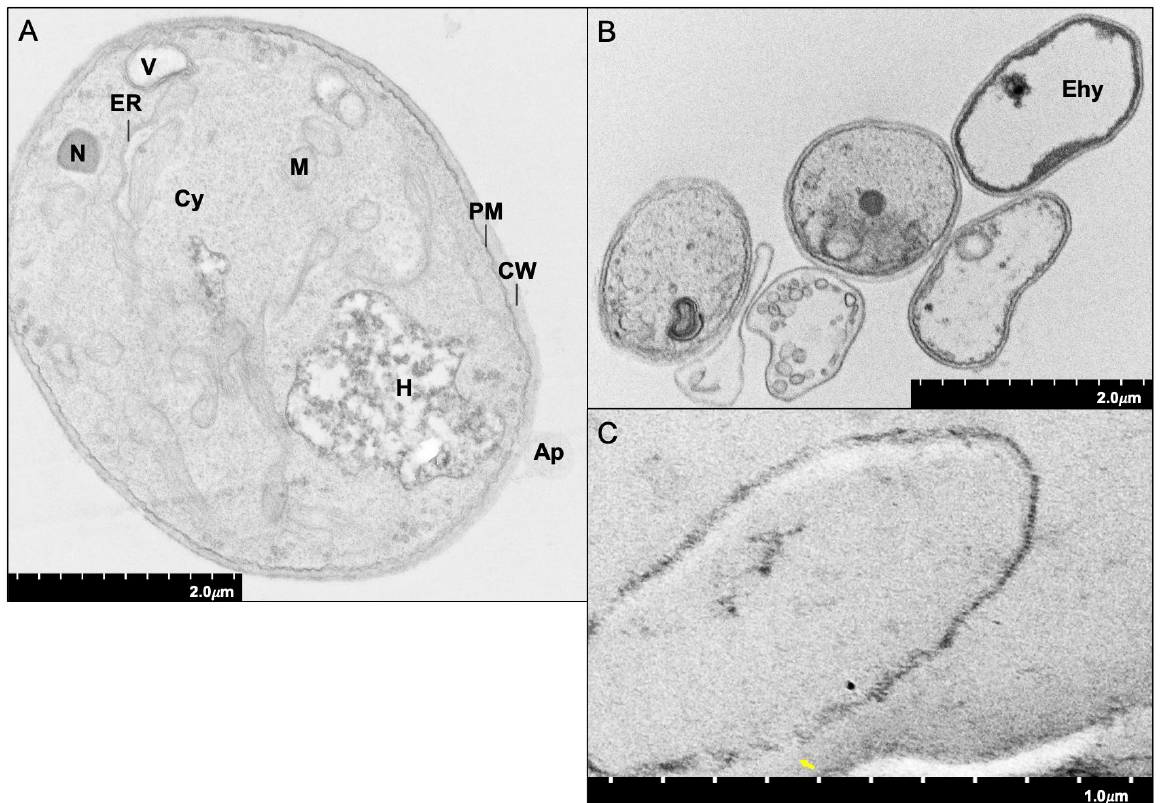
Figure 1. Morphogenesis of biotrophic mycoparasitism of S. mycoparasitica on a Fusarium host. The micrographs of TEM (magnification × 12.0k) were derived from the samples (co-culture of S. mycoparasitica (3 days pre-inoculated) with Fusarium isolate for 3 days on PGA plate ( A ); co-culture of S. mycoparasitica with Fusarium isolate for 8 days on PGA slide culture ( B , C )). Ap, appressorium; CW, cell wall; Cy, cytoplasm; Ehy, empty hypha; ER, endoplasmic reticulum; H, haustorium; M, mitochondrion; N, nucleus; PM, cell membrane; V, vacuole.